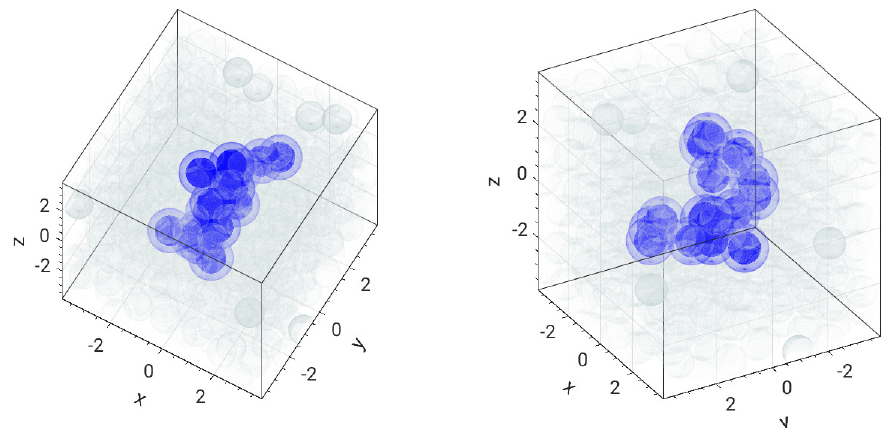
Figure 5. Two views of a snapshot of a typical large soft cluster composed of 15 monomers. Bond strength k = 10 3 . Gyration radius R g = 1.89, principal values of the inertia tensor I 1 = 26.4, I 2 = 30.5, and I 3 = 50.4. The blue color corresponds to particles with unit diameter (the approximate monomer diameter). Two soft monomers are defined as “close”, and then belongs to the cluster, if their surrounding lighter regions superimpose, i.e., their mutual distance r ≤ 1.5, see Figure